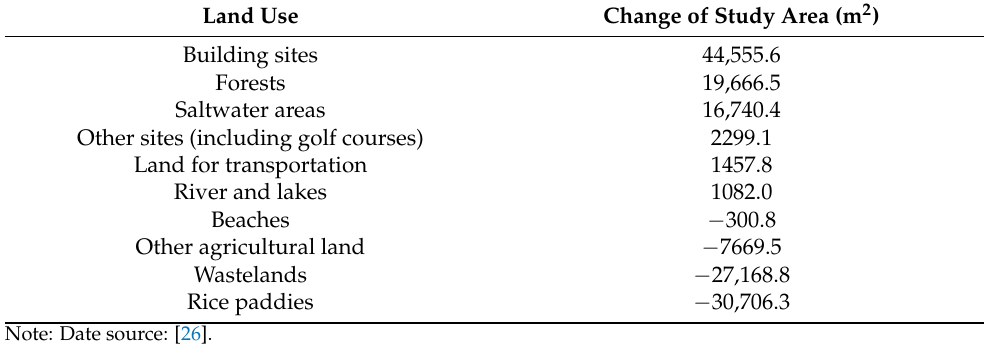
Table 3. Changes in land use (average of the study areas).